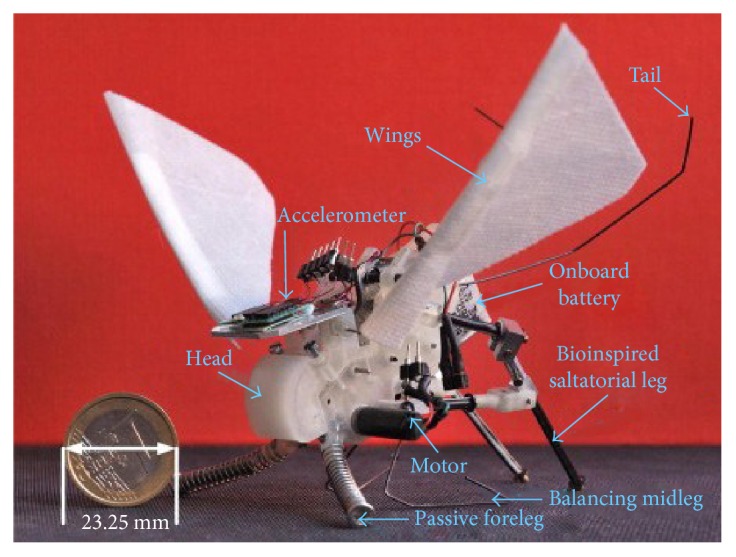
Jumping robot Grillo III [43].